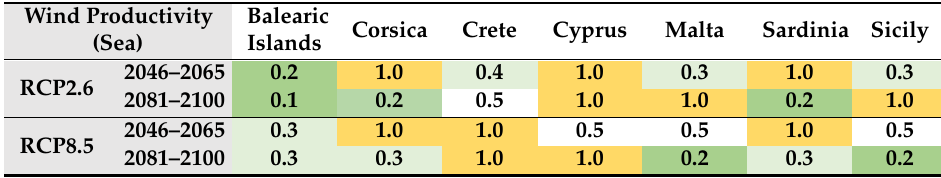
Table A2. This is equivalent to Table A1, but this is computed over the sea. Domains used to do the calculations are presented in Table